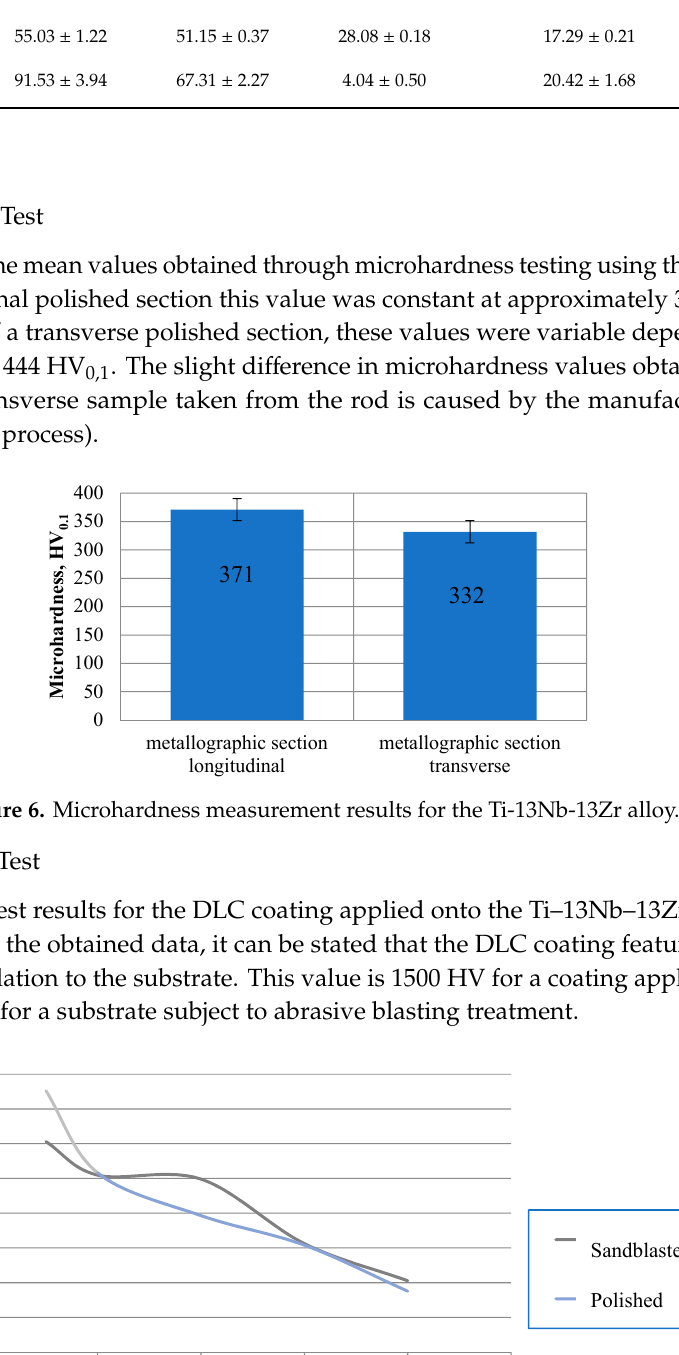
Figure 5. Example contact angle measurement for a sample: ( a ) polished, initial state, ( b ) sand ‐ blasted,